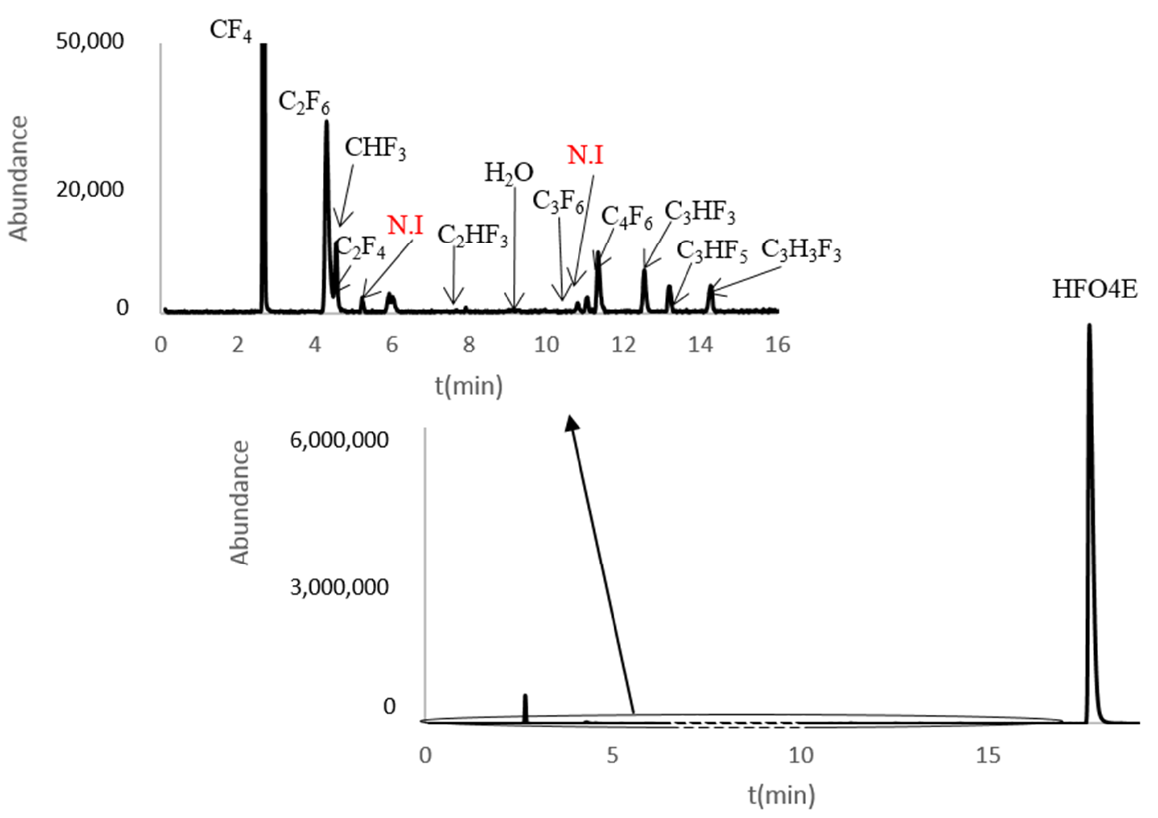
Figure 5. GC/MS chromatogram for a gas mixture of 21.7% ( v / v ) of HFO4E in N 2 after an electric arc of approximately 140 kJ.